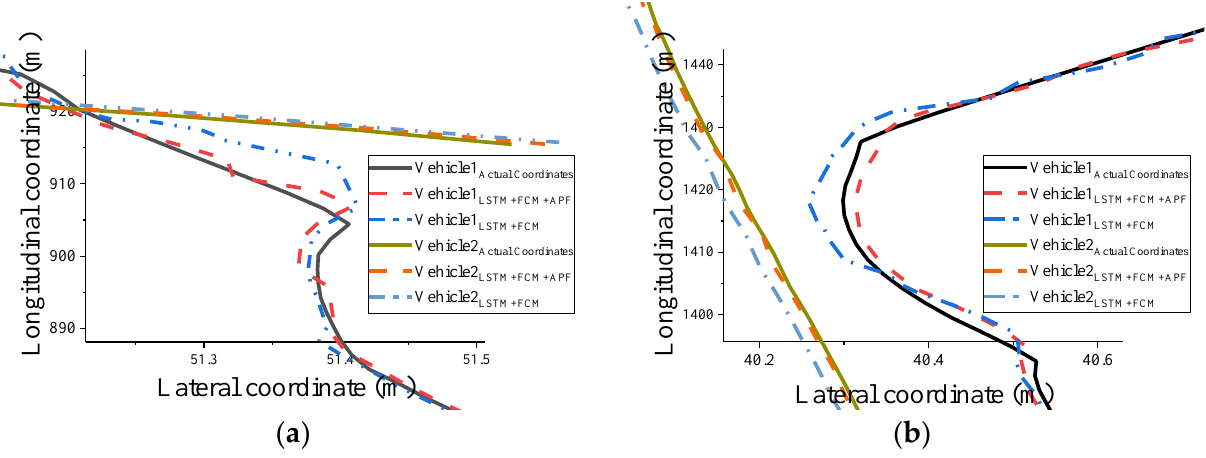
Figure 7. Multi-vehicle trajectory prediction results: ( a ) future 5 − step prediction results and ( b ) future 10 − step prediction results.